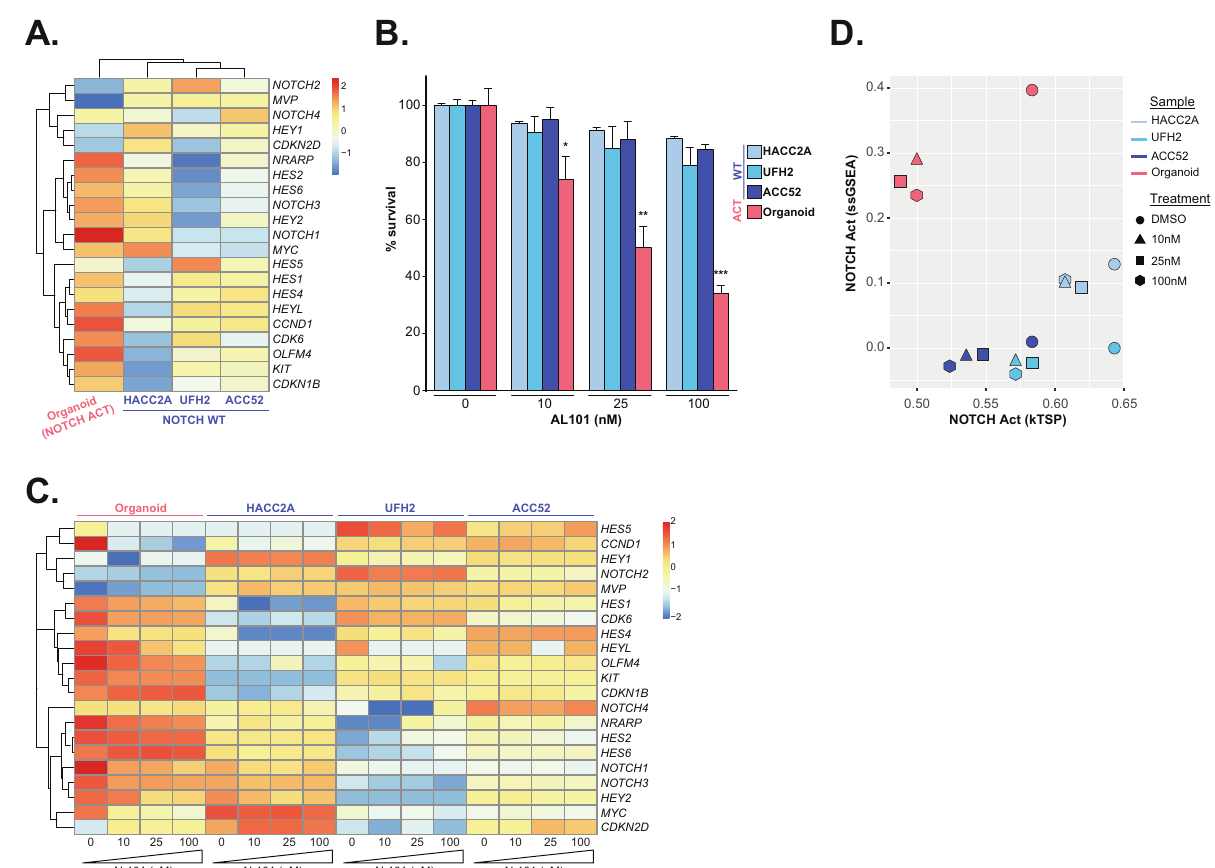
Fig. 1 AL101 inhibits NOTCH activation and cell viability in a NOTCH1-mutated ACC organoid but not in NOTCH wild-type ACC cell lines. A Hierarchical clustering of normalized baseline expression of 21 NOTCH-related genes in an organoid bearing NOTCH1 activating mutations and three ACC cell lines with wild-type NOTCH genes displayed as a heatmap. Higher or lower expression of genes is indicated with shades of red or blue cells, respectively. B In vitro ACC cell models were treated with increasing concentrations of AL101 and relative cell viability was determined on day 14. * p < 0.05, ** p < 0.01, and *** p < 0.001. C Normalized expression of 21 NOTCH-related genes in the ACC in vitro cell models treated with increasing concentrations of AL101 displayed as a heatmap. Higher or lower expression of genes is indicated with shades of red or blue cells, respectively. D NOTCH activation caller plot scores the level of NOTCH signaling activity in the indicated samples by using ssGSEA (axis Y) and kTSP (axis X) algorithms on a set of NOTCH-related genes, where a shift down and to the left indicates reduced NOTCH signaling